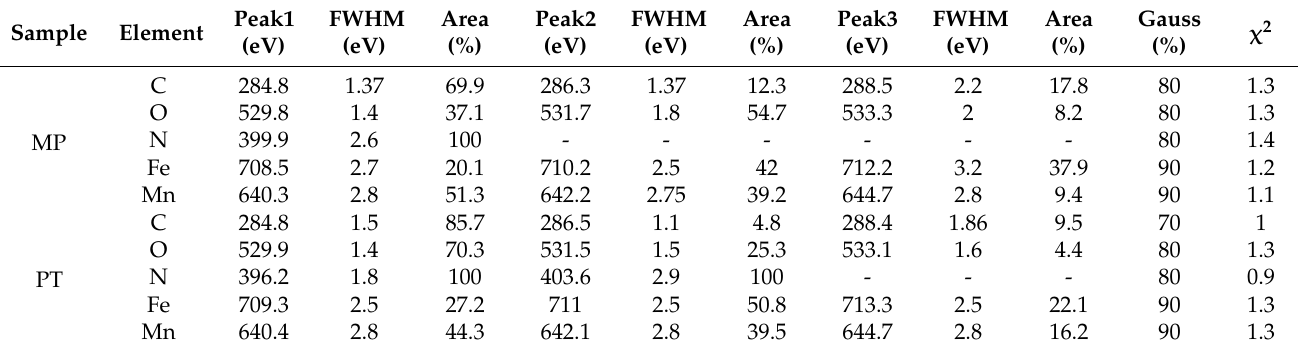
Table 3. MP and PT condition binding energy and FWHM values, percentage areas, Gaussian fraction and χ 2 for C1s, O1s, N1s, Fe2p3 and